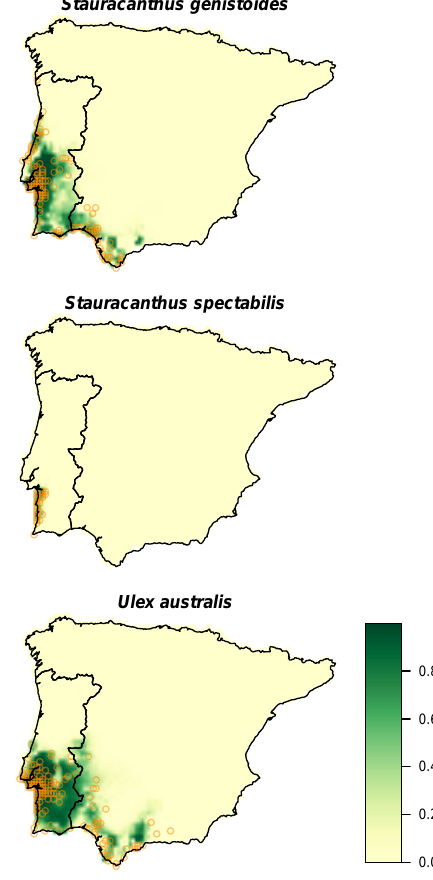
Figure 1. Habitat suitability maps for the three keystone indicator species, computed using Mahalanobis distance. Habitat suitability ranges from 0 (low suitability) to 1 (high suitability). Orange circles represent species occurrence